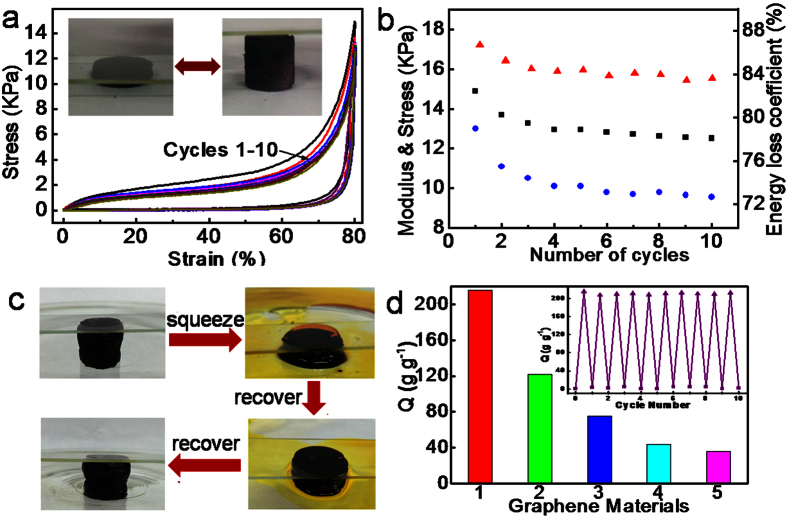
Compression and oil absorption tests of GA-3.(a) Stress-strain curves of compressions of the 10 cycles on GA-3, exhibiting elastic deformation. Inset, photographs of the GA under a compressing and releasing cycle. (b) The corresponding Young’s modulus (blue circles), retention of maximum stress (black squares) and energy loss coefficient (red triangles) for different cycles obtained from (a). (c) Recycling absorption approach for GAs absorbers, showing excellent repeated absorption of n-hexane (dyed with Sudan orange G). (d) Comparison of n-hexane absorption capacities (Q) for different graphene based materials: (1) GA-3 synthesized in this work, (2–5) graphene sponges reported in ref. 7, 40, 41 and 11, respectively. The inset shows absorption recyclability of GA-3 for n-hexane.